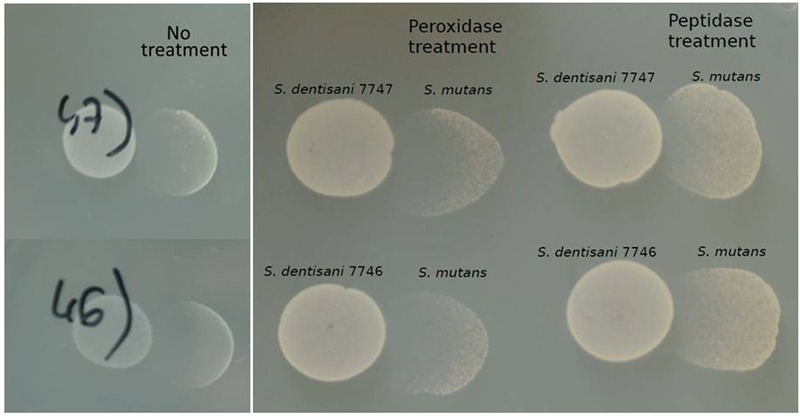
Inhibition of S. mutans by S. dentisani in the presence of peroxidase and proteinase. The tests were performed with S. dentisani strains 7746 and 7747, treating with the enzymes the spots where S. mutans would later be grown. The controls on the left panel show the inhibition without treatment.